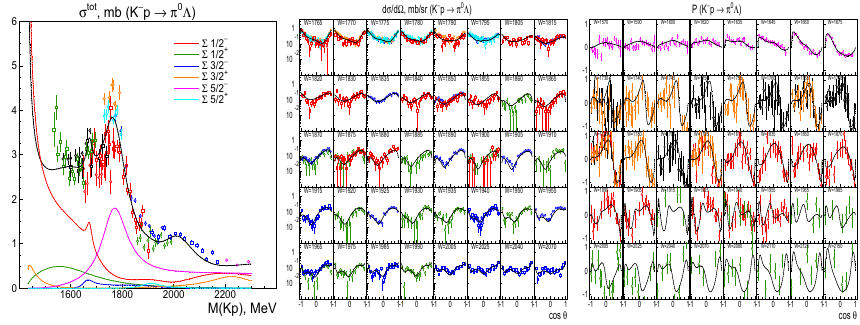
Figure 5. The description of the K − p → K 0 Λ data and the contributions from leading partial waves. The data are from [11], [12],[13], [14],[15], [16],[17], [18],[19],[20].